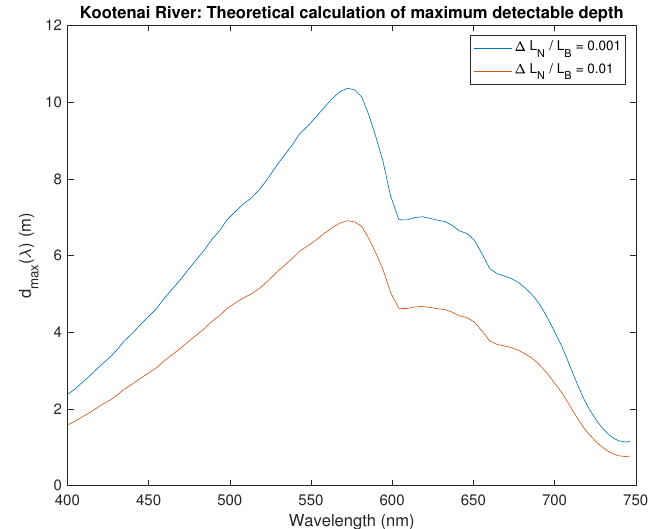
Figure 6. Theoretical calculations of the maximum detectable depth based on optical field measurements and Equations (1) and